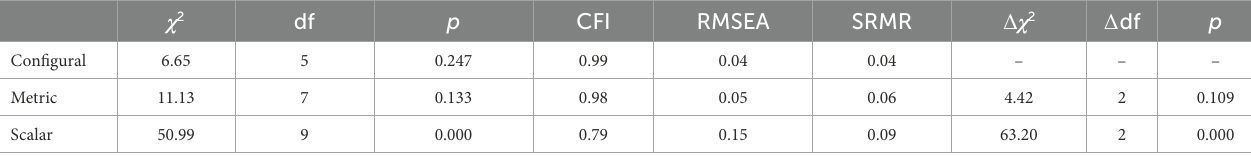
TABLE 3 Model fit comparison of the three models for the examination of measurement invariance.